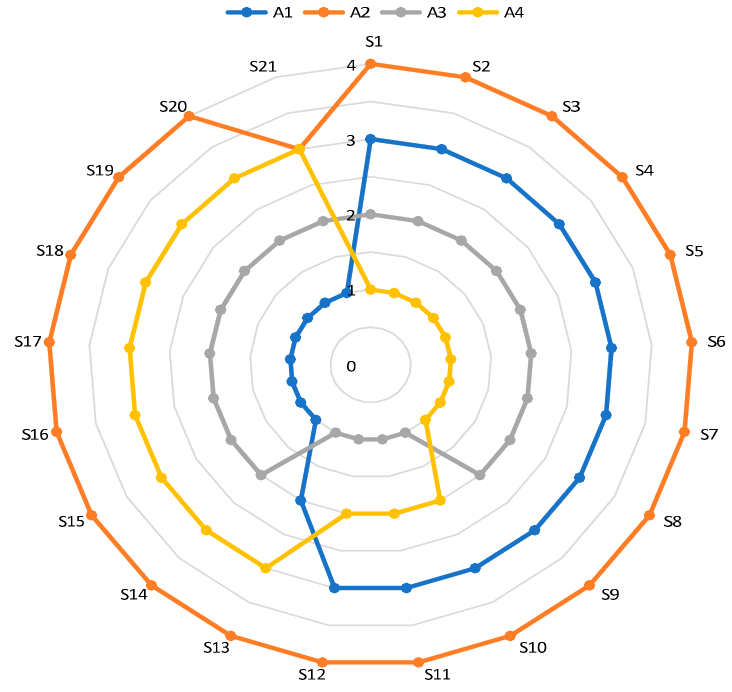
Figure 5. Sensitivity analysis of alternative rankings across 21 scenarios.